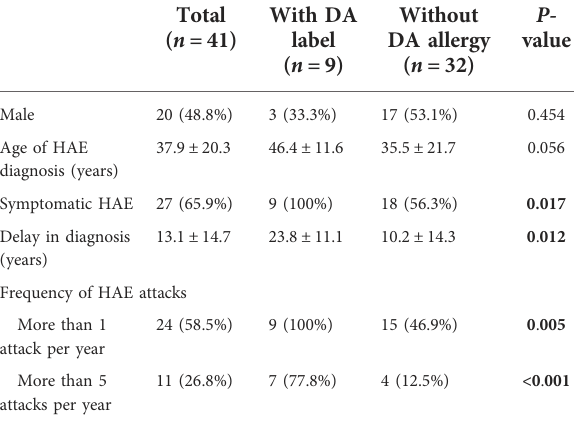
TABLE 1 Demographics and clinical characteristics of HAE patients with or without DA labels.